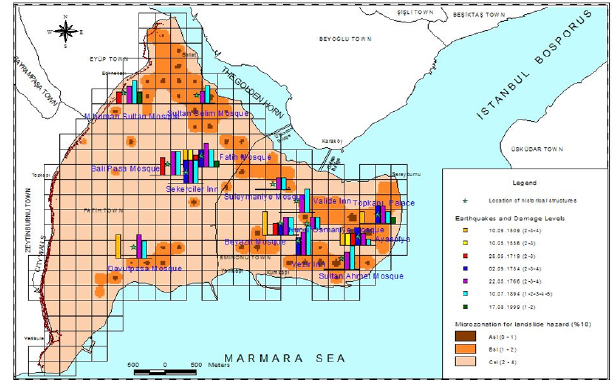
Figure 15. Comparison of damage levels in various earthquakes and Ground shaking Fig. 15. Comparison of damage levels in various earthquakes and microzonation map prepared for probability of exceedance of 10% in 50 years. ( İ nce, 2005) Ground shaking microzonation map prepared for probability of ex- ceedance of 10% in 50yr. (˙Ince, 2005)